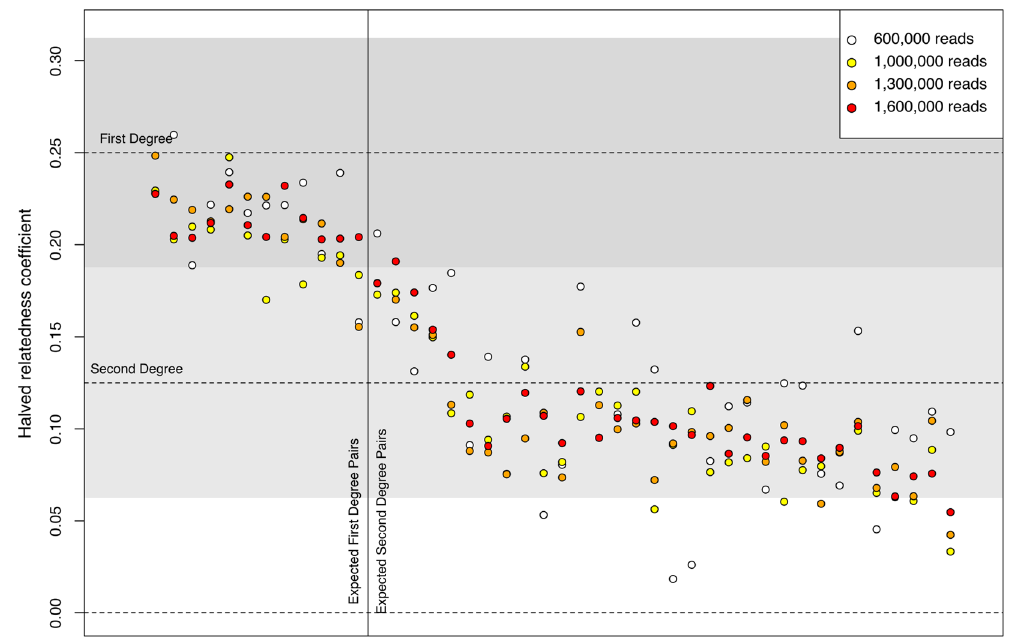
Figure 2. Coefficients of the 44 relationships for 1st- and 2nd-degree relatives from the Neolithic site of Koszyce 15 . Each vertical set of 4 coloured points corresponds to one pair of individuals tested with different numbers of aligned reads, according to the legend. Relationships to the left of the solid vertical line are known to be 1st-degree, as per Schroeder et al. 15 , and relationships to the right of the line are expected to be 2nd-degree. Grey areas define 1st- and 2nd-degree range